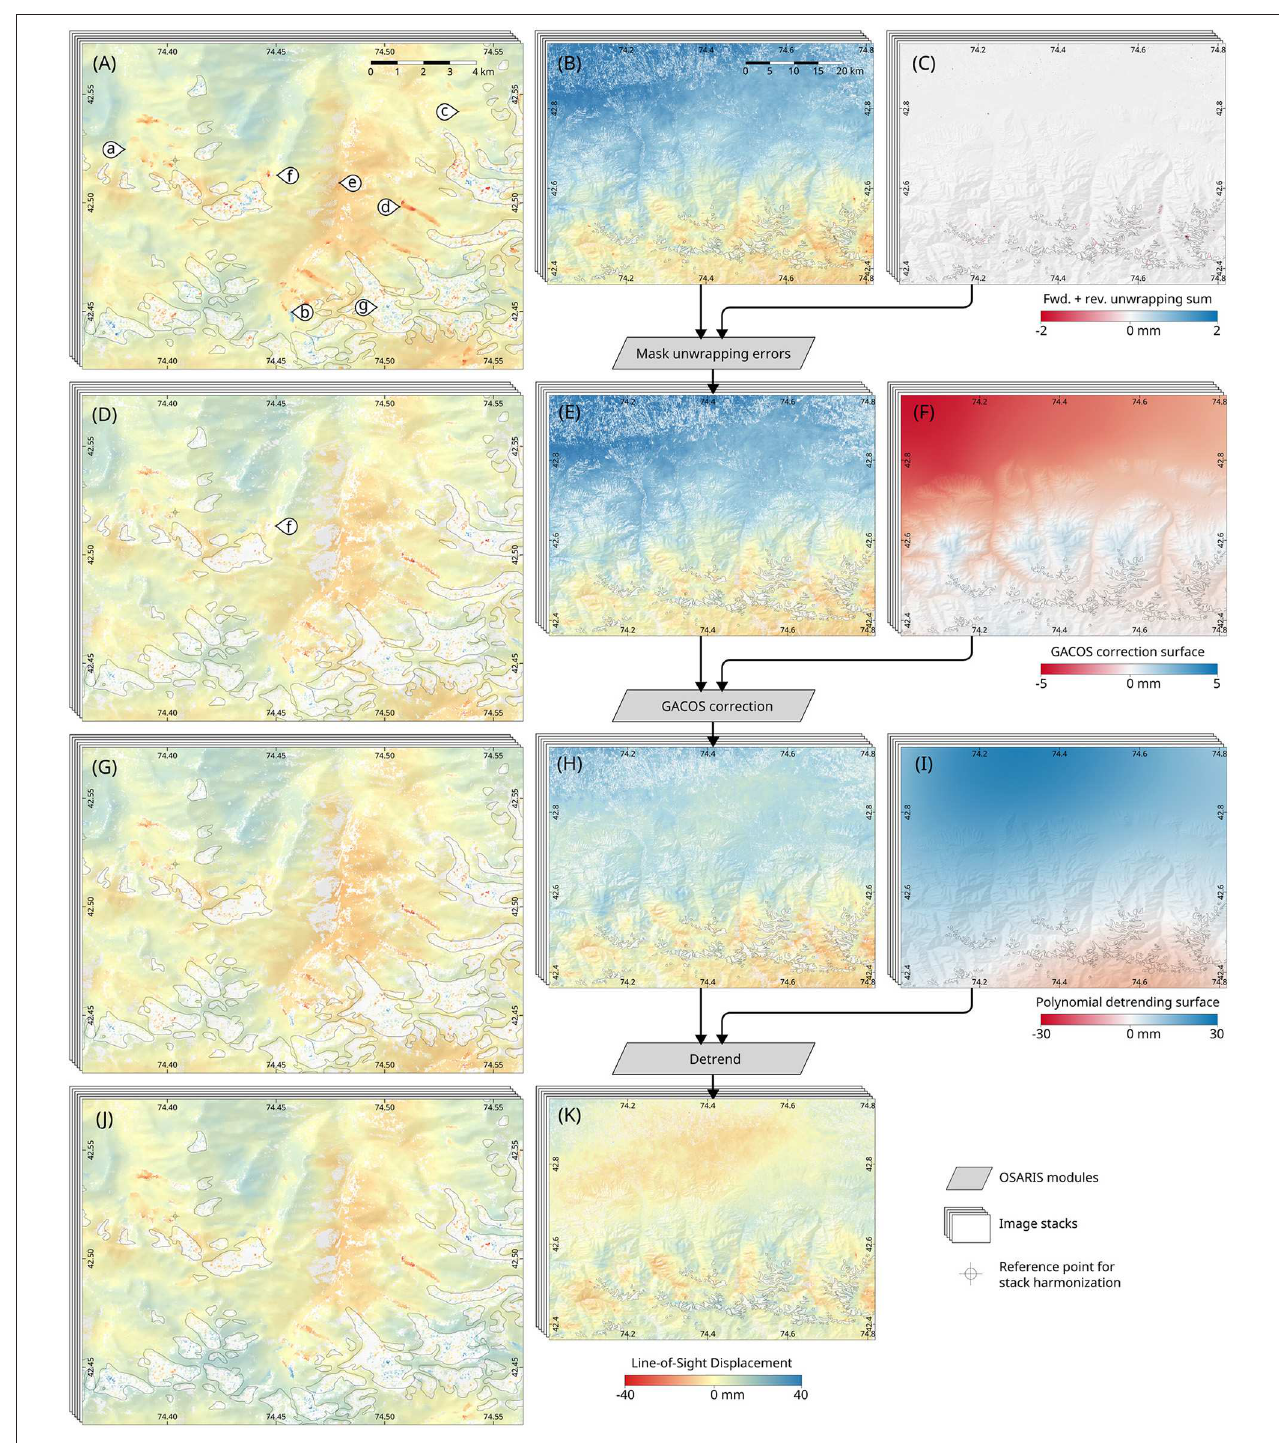
FIGURE 8 | Example processing chain for Line-of-Sight displacement (LOSD) results, demonstrated with the scene pair 2018-08-05 to 2018-08-17. Left and middle columns show results for the core and wider study area, respectively. The right column presents supplementary datasets that are used in the next processing step. (A,B) Harmonized LOSD dataset and (C) forward plus reverse pair unwrapping sums which are used to mask phase unwrapping errors. (D,E) Masked LOSD and (F) GACOS correction surface which is used to correct for atmospheric signal delays. (G,H) LOSD after GACOS correction and (I) polynomial surface used to remove large-scale trends. (J,K) LOSD after trend removal. Note that each processing step was automatically applied to the whole stack. Markers in (A) indicate (a) a rock glacier, (b) a Little Ice Age moraine ridge, (c) a gully, (d) a proglacial drainage channel, (e) striped artifacts, (f) a region of deficient phase unwrapping that was masked in (D) , and (g) patchy extreme values over a glacier. A semitransparent hillshade based on SRTM DEM data and glacier outlines from Randolph Glacier Inventory v6.0 were added for orientation. Contains modified Copernicus Sentinel data 2018.